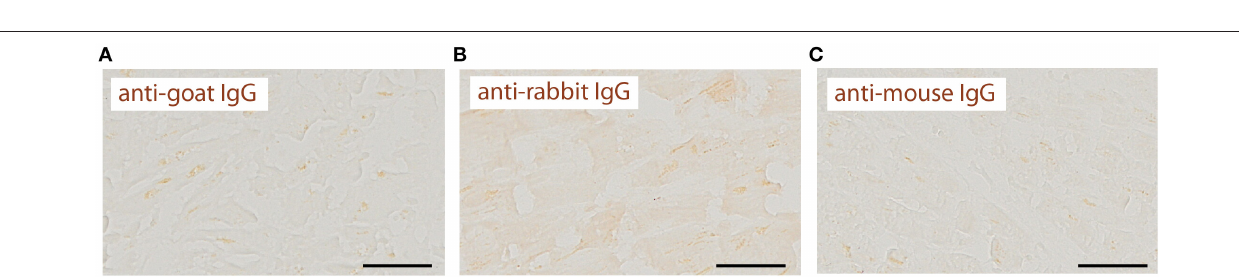
injury or fibrosis (25). Increased expression of FN1 in the diseased hearts alludes to its role in fibrosis that is a major pathology of both DM and HFpEF. DNM2 is involved